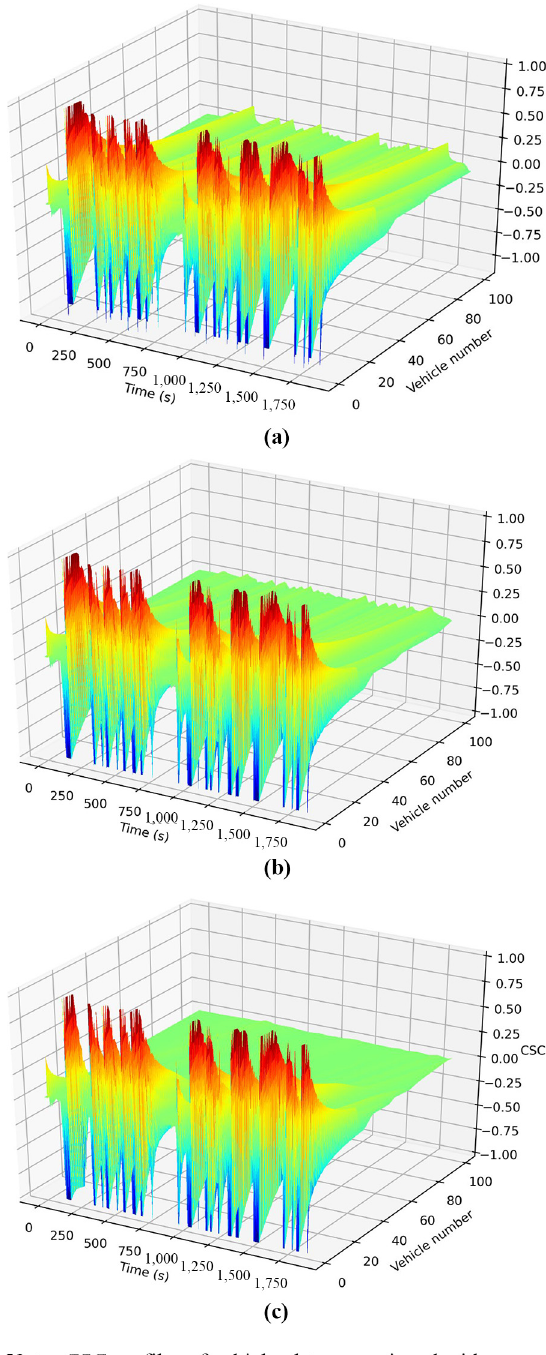
Figure 3 CSC pro fi les of vehicle platoon equipped with SDM, EcoSDM and